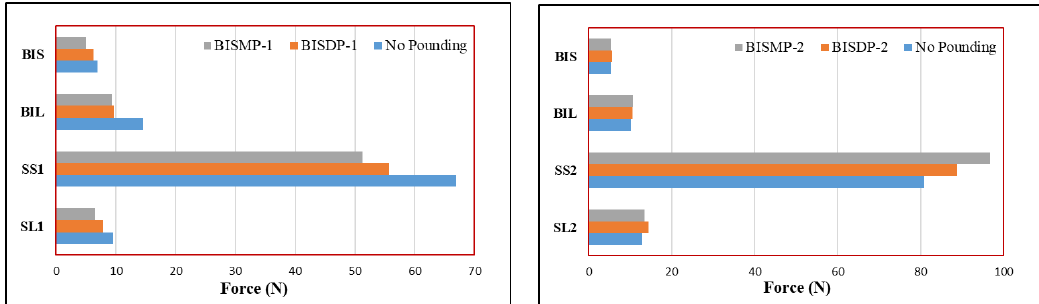
Figure 11. Maximum horizontal force in stiffer base-isolated models. Table 11. The pounding effect between stiffer base-isolated models.